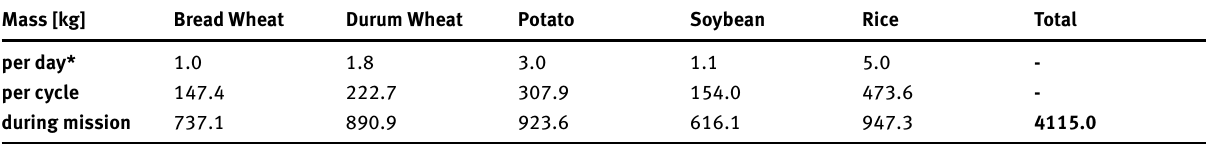
Table 4: Dry edible biomass production.